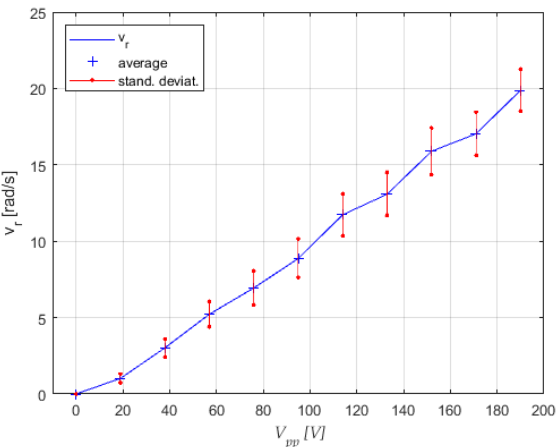
Figure 12. Measurements of the rotational speed of water streaming v r versus sine and cosine voltage amplitudes V pp at f = 400 Hz for the vibrational pot-like mechanism.